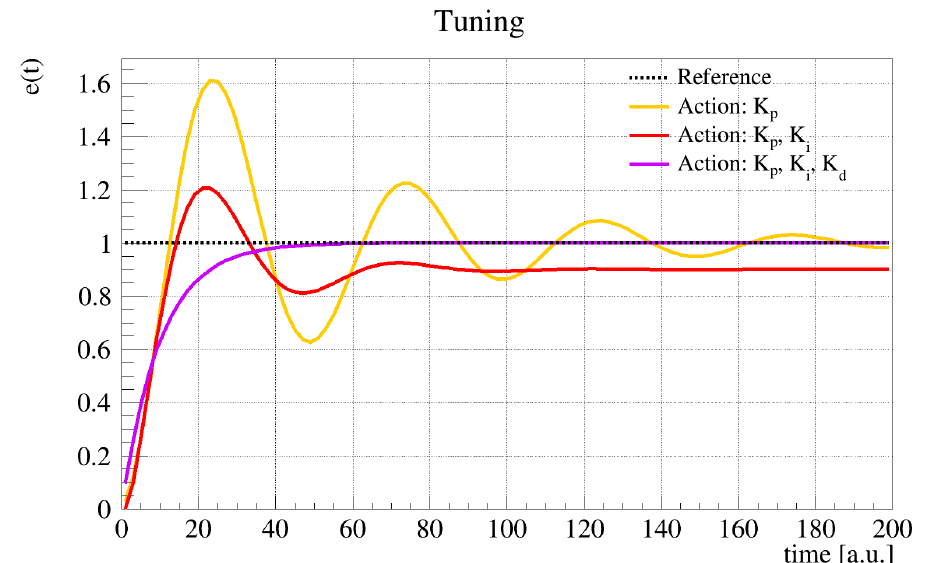
Figure 3. Tuning example: simulation of a generic system responding respectively to a pure propor- tional control (red), a proportional corrected with the integral term (yellow) for removing the bias with the set-point (dashed black) and finally with oscillation damped by the integral term (violet). The values used here for the proportinal, derivative, and integral terms are K p = 1, K d = 0.4, and K i = 0.2,